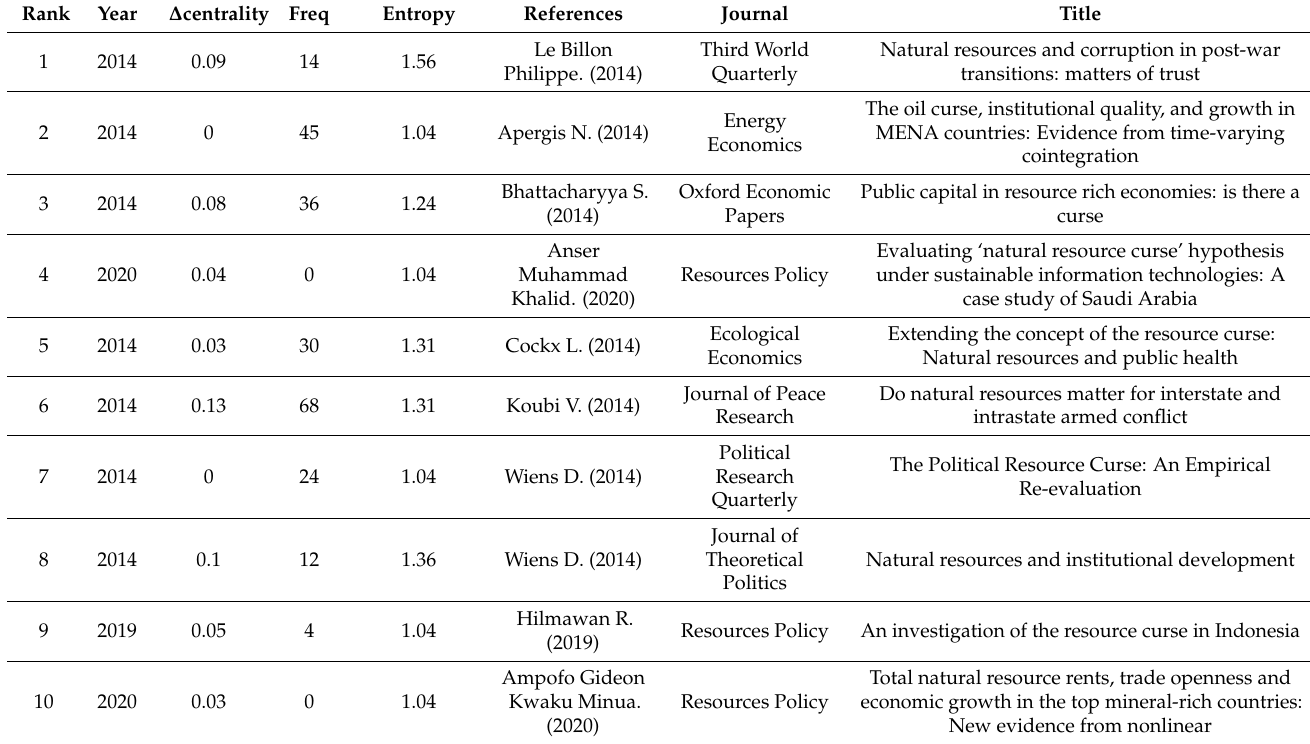
Table 12. Recent Potentially transformative